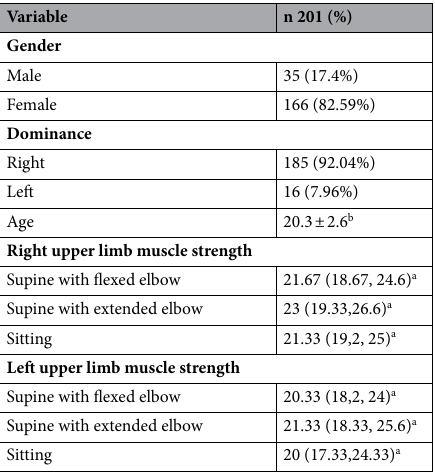
Table 1. Characteristics of the participants. a Data are presented as median (quartile 25, quartile 75). b mean ± standard deviation.